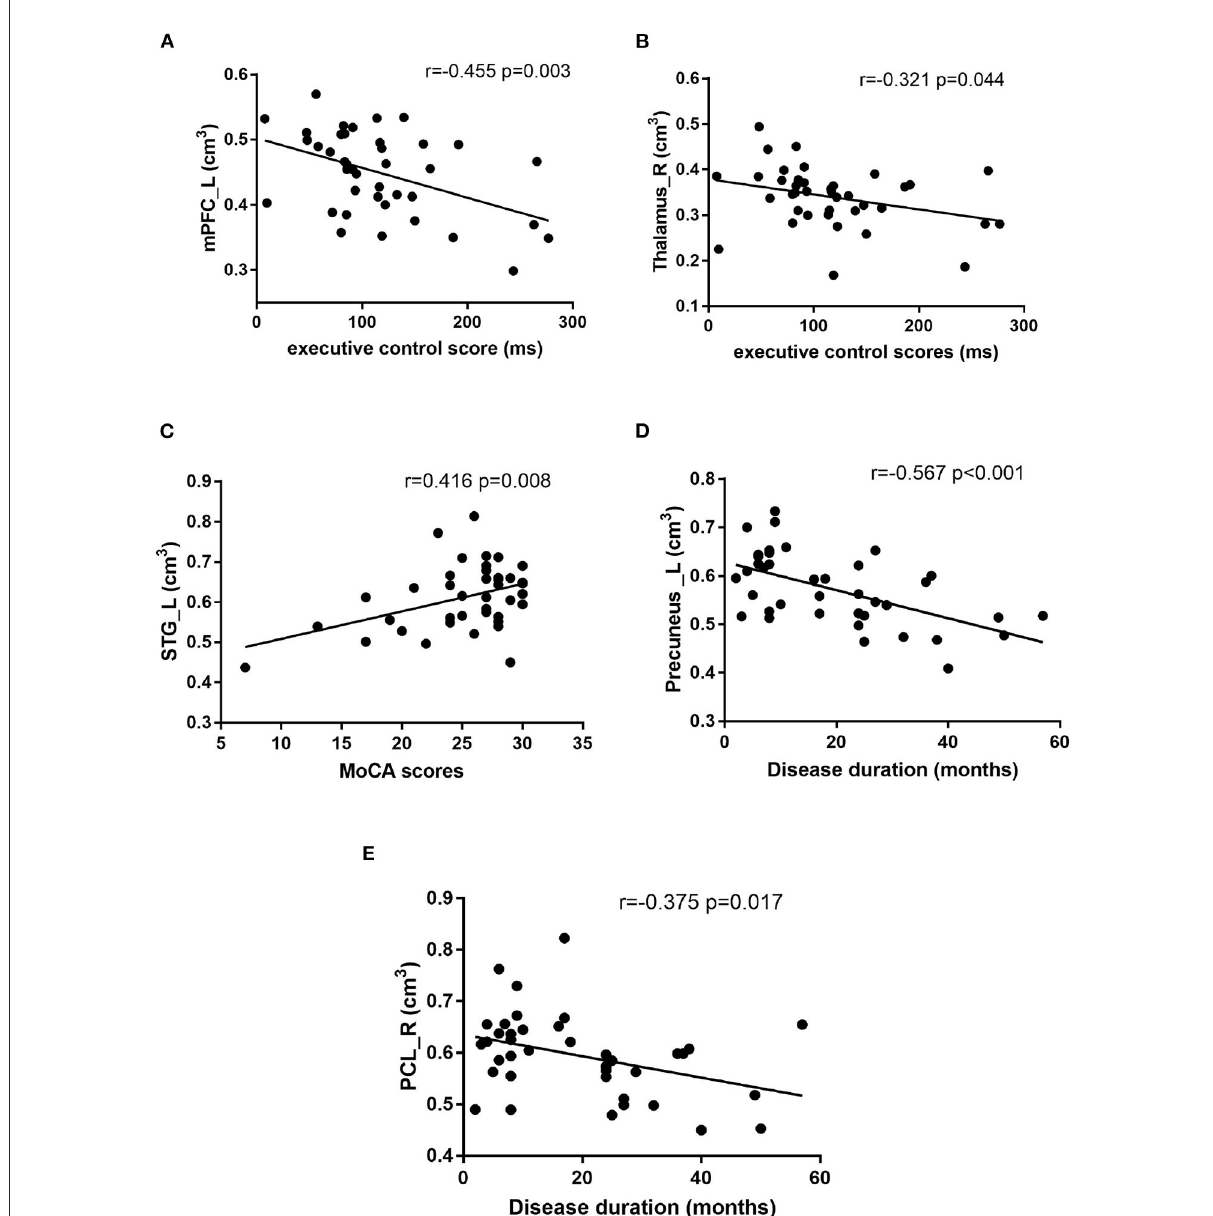
FIGURE3 Correlation analysis: (A) The executive control (EC) scores was negatively correlated with the left medial prefrontal cortex (mPFC_L) volume ( r = − 0.455 p = 0.003), (B) The EC scores was negatively correlated with right thalamus volume ( r = − 0.321 p = 0.044), (C) The Montreal Cognitive Assessment test (MoCA) scores was positively correlated with left superior temporal gyrus (STG_L) volume ( r = 0.416 p = 0.008), (D) The disease duration was negatively correlated with the left precuneus volume ( r = − 0.567 p < 0.001), (E) The disease duration was negatively correlated with the right posterior cerebellum (PCL_R) volume ( r = − 0.375 p =